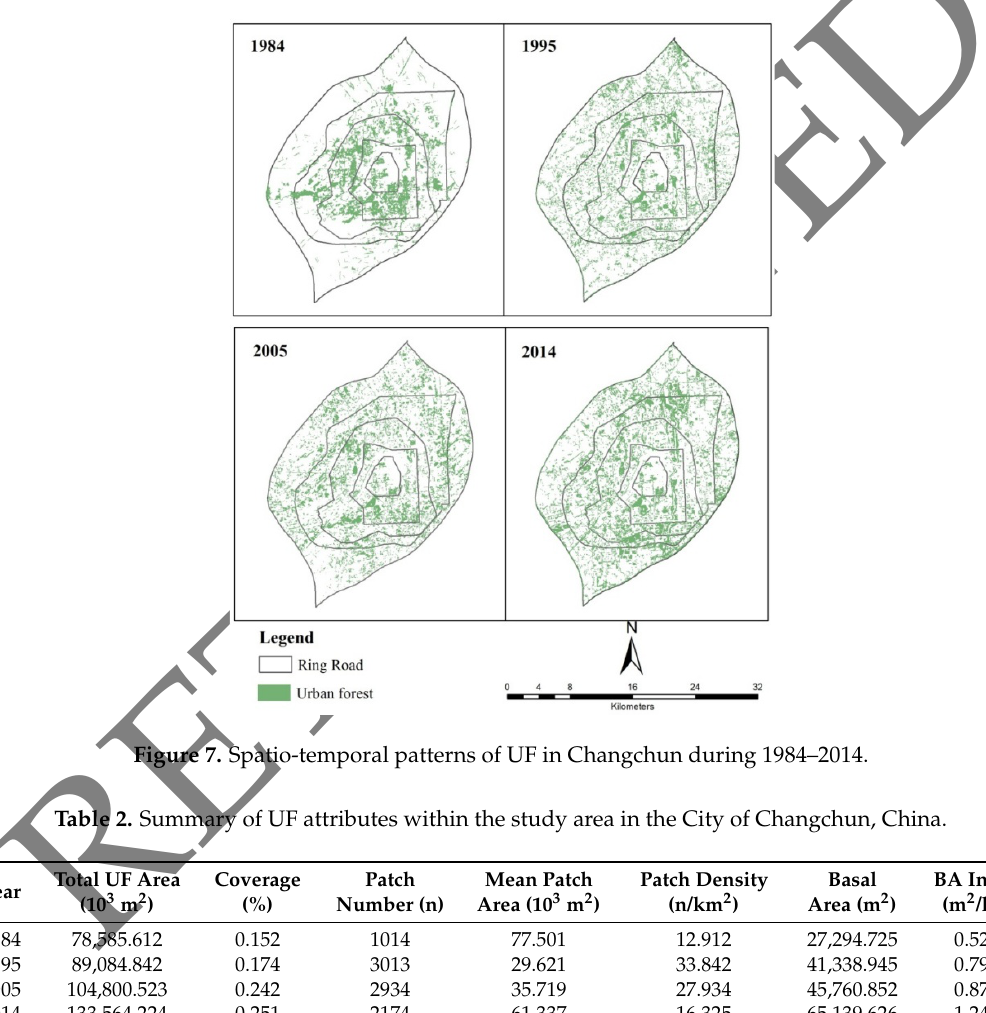
Table 2. Summary of UF attributes within the study area in the City of Changchun, China.